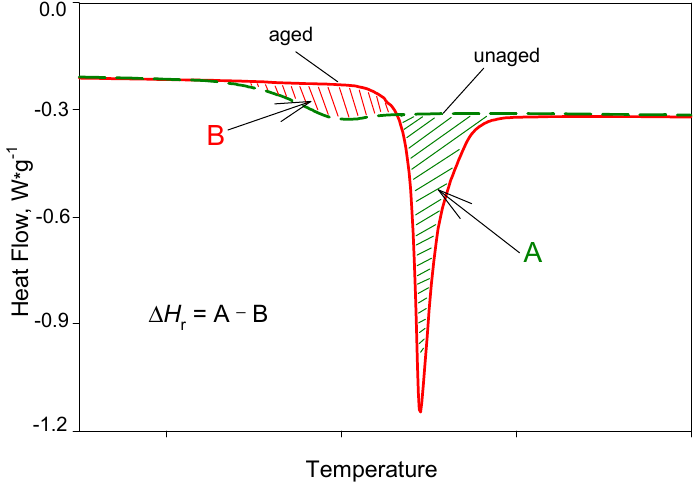
Figure 6. Scheme for the determination of the enthalpy relaxation ( ∆ H r ) from the plots of heat-flow vs. temperature. The enthalpy relaxation was calculated by subtracting the areas created between aged and unaged samples.